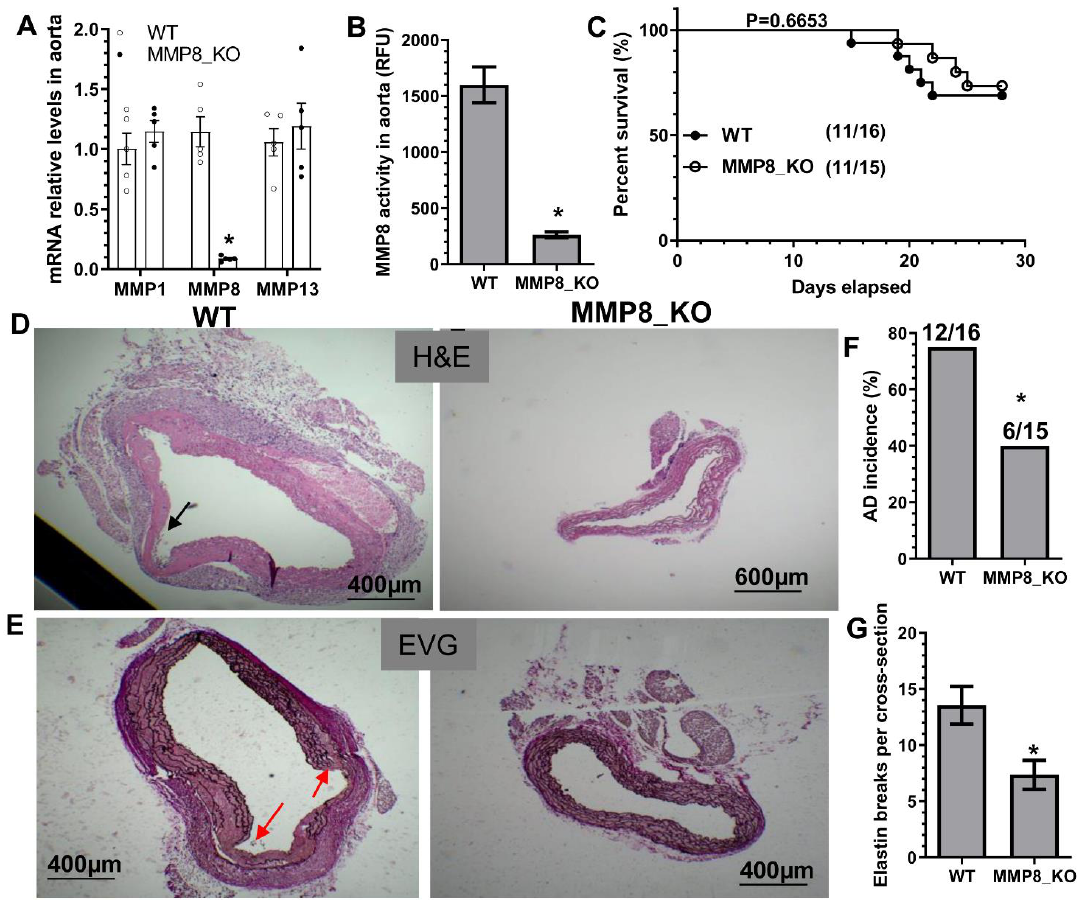
Figure 1. A causal role for MMP8 in BAPN-induced TAD formation. Three-week-old MMP8- knockout mice (MMP8_KO, ApoE −/− /MMP8 −/− ) and their wildtype control littermates (WT, ApoE −/− /MMP8 +/+ ) administered with BAPN in drinking water for two ( A , B ) or four ( C – G ) weeks, respectively. ( A ) Thoracic aortic gene expression was analyzed by RT-qPCR. ( B ) Thoracic aortic MMP8 activity was measured using SensoLyte ® 520 MMP-8 Assay Kit. ( C ) Animal survival rate (Log-rank (Mantel – Cox) test). Images for HE staining ( D ), EVG staining ( E ), and the quantitative data of AD incidence ( F ) and elastin breaks ( G ) are presented here. Note: Thoracic AD incidence was defined by the mice that died from thoracic aortic rupture, and mice identified with one or more aortic pathologies (aortic intima tear, false lumen, and intramural hematoma). Black or red arrows indicate AD or intima tearing. Data presented here are representative ( D , E ) or the mean ± SEM of five ( A , B ) or eleven mice ( C – G ), respectively ( n = 5 or 11 mice). * p < 0.05 (versus WT, unpaired t - test in A , B , G ; Chi-square test in F ). 3.3. Pharmacological Inhibition of MMP8 Decreased TAD To explore a therapeutic value of MMP8 inhibition in BAPN-induced TAD formation, we treated WT mice with an in vivo potent and highly specific MMP8 inhibitor (MMP8i, CAS 236403-25-1), as previously described [24 – 26]. While aortic MMP8 gene expression was not affected by MMP8i treatment (Figure 2A), it caused a significant decrease in aortic MMP8 activity (Figure 2B). Similar to MMP8 gene deletion, MMP8i treatment caused no apparent change in survival rate (Figure 2C) but resulted in decreased levels of TAD incidence and elastin fragmentation (Figure 2D – G),